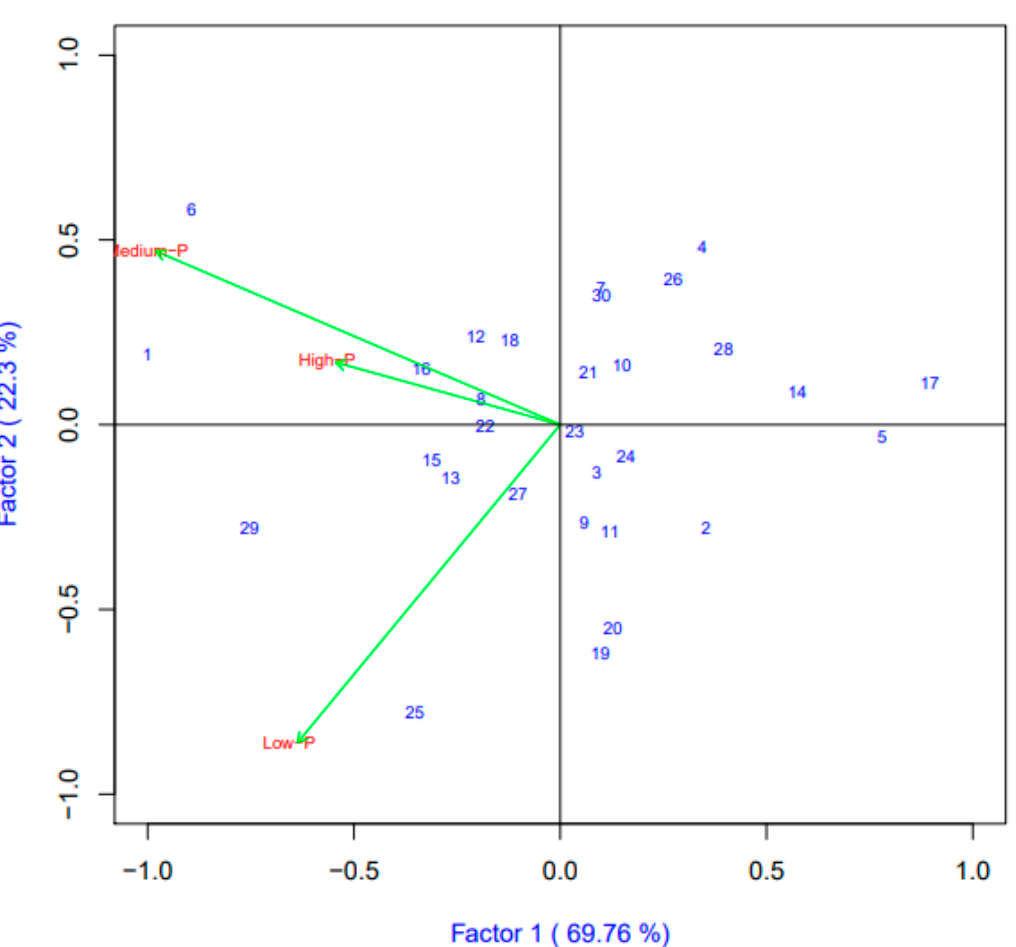
Figure 7. Genotype main effect plus Genotype by Environment (GGE) biplot displaying the genotypes for grain Zn content at varying soil P levels. Factors 1 and 2 are the principal component axis. Low-P = no P application of P 2 O 5 , Medium-P = 10 kg P 2 O 5 ha − 1 , and High-P = 60 kg P 2 O 5 ha − 1 for field evaluation.